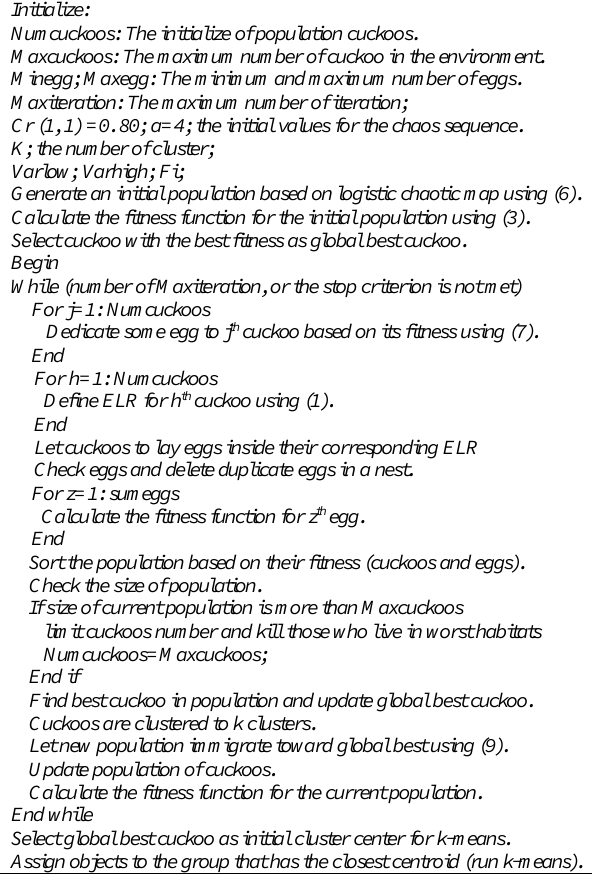
Figure 6. Pseudo-code for hybrid ECOA-K algorithm.